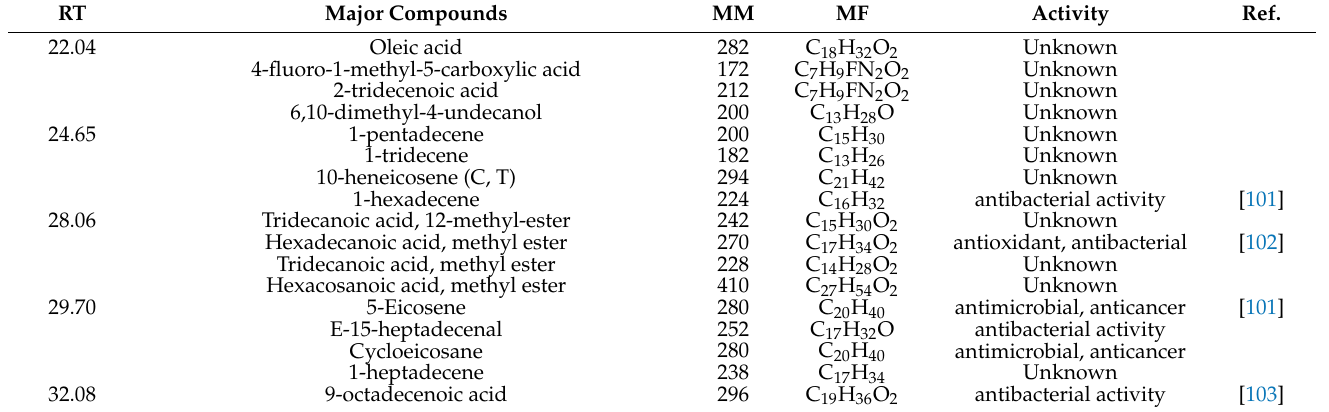
Table 9. GC-MS analysis of bioactive compounds produced by Pseudomonas aeruginosa A7.